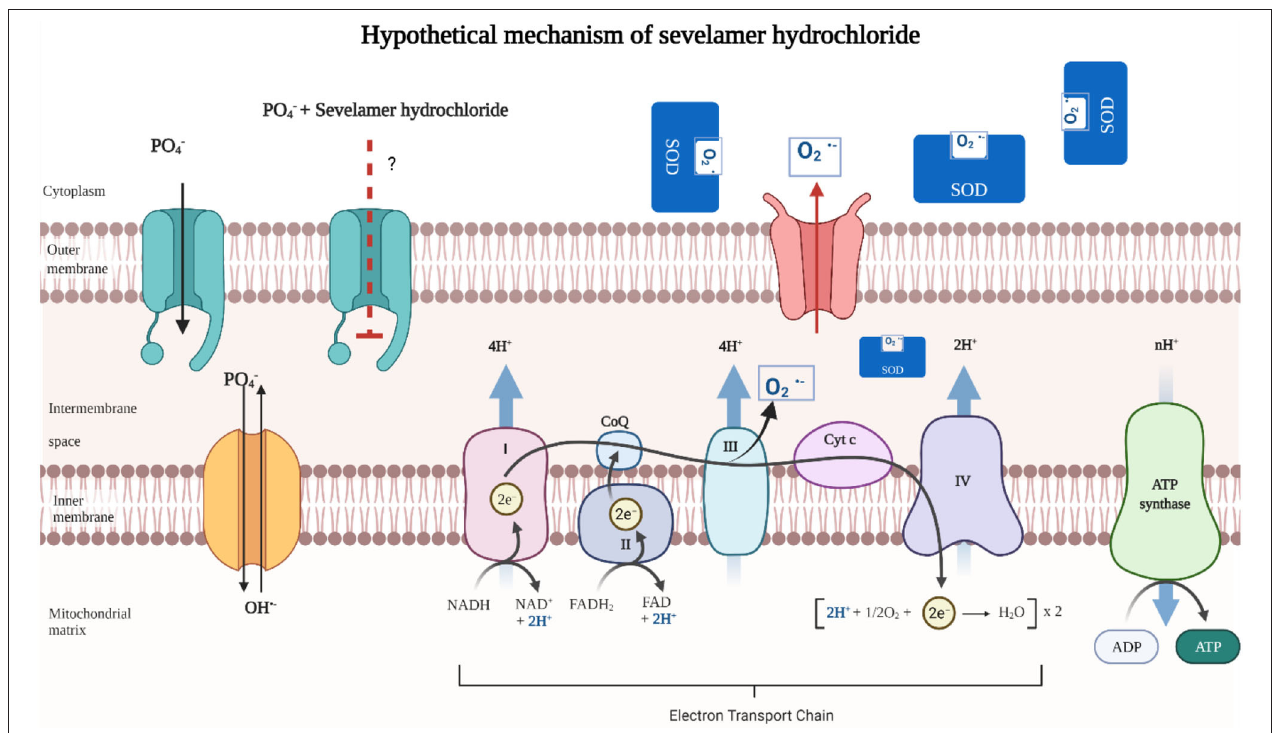
FIGURE 2 | Hypothetical mechanism of sevelamer hydrochloride in oxidative stress (OS). Increase in extracellular Pi causes mitochondrial OS conditioned by mitochondrial hyperpolarization produced by a phosphate-hydroxyl exchange. Hyperpolarization stimulates the electron transport chain and increases the concentration of superoxide radicals by complex III. The binding of Pi to sevelamer hydrochloride could explain the antioxidant mechanism by reducing mitochondrial OS